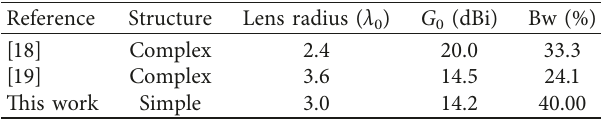
Table 1: Comparisons with previous works of ultra-wideband dielectric lens antennas for beamsteering